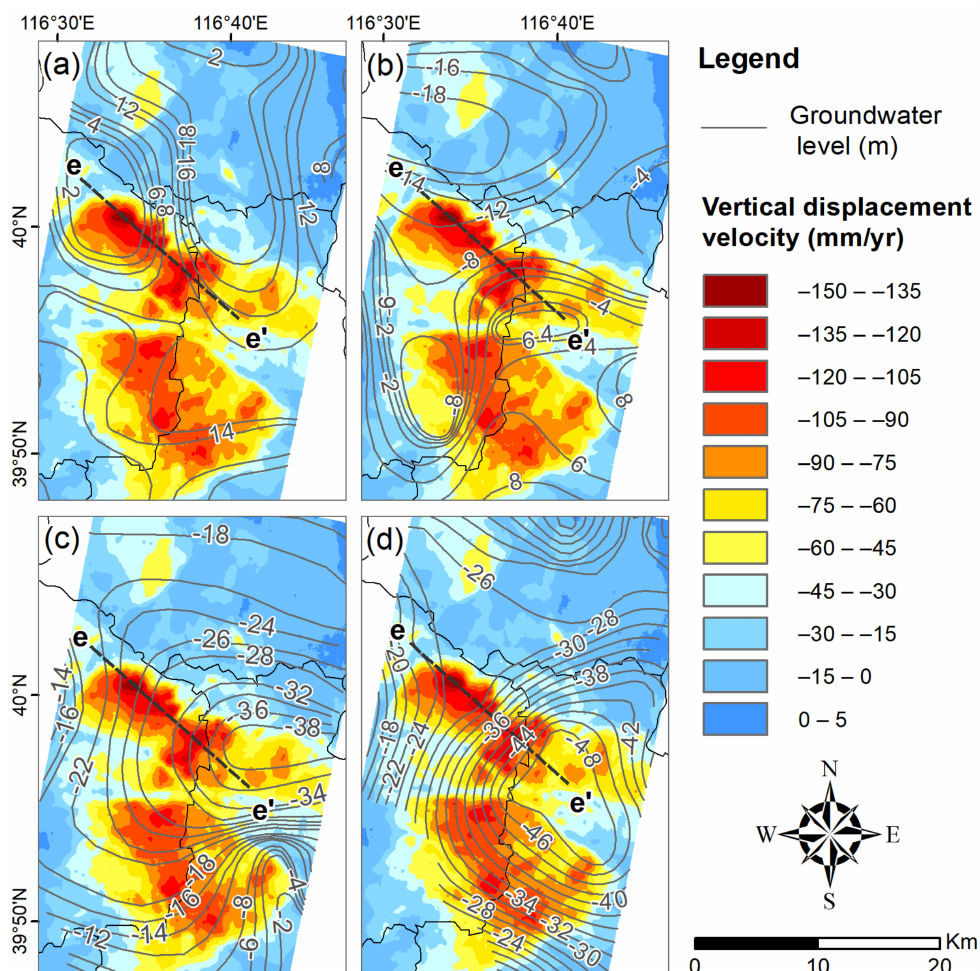
Figure 12. Spatial relationships between the groundwater level and vertical displacement. The contours in ( a – d ) represent the water levels of the unconfined aquifer, the first confined aquifer, the second confined aquifer and the third confined aquifer, respectively. e–e’ is displacement profile within depressions are marked by black dashed